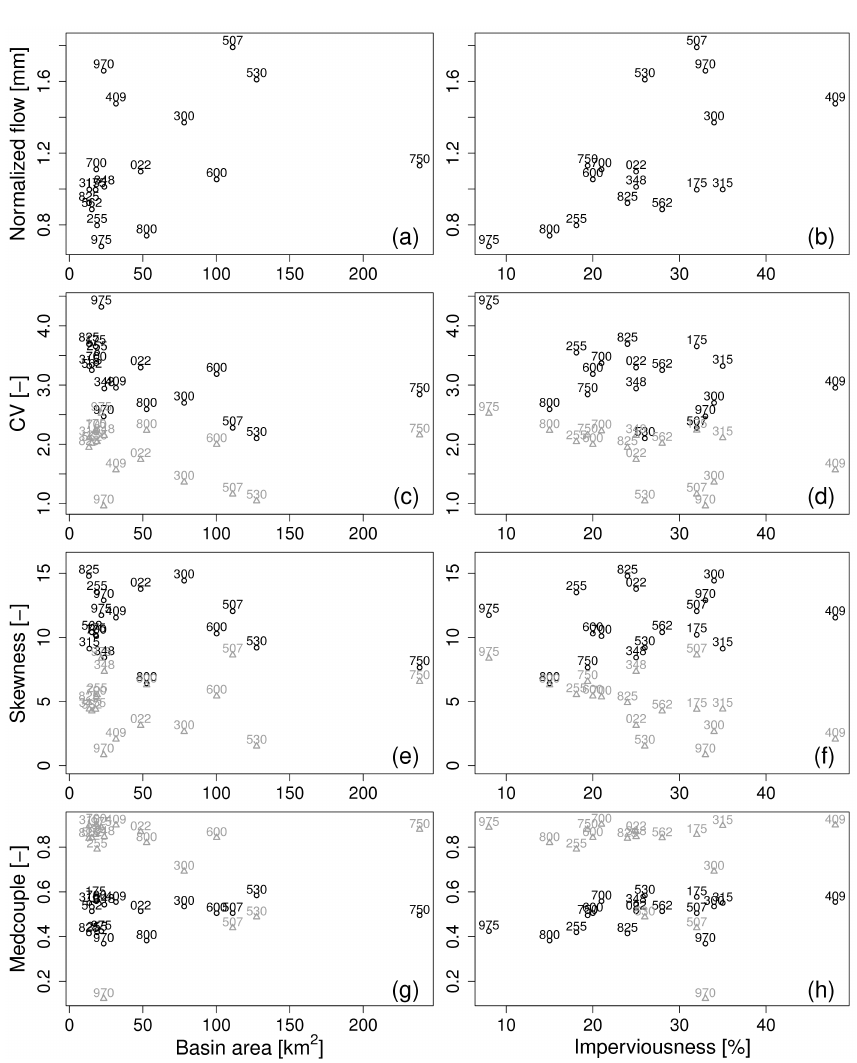
Figure 5. Scatter plots for mean normalised flow inter-amounts (a, b) , coefficient of variation (c, d) and medcouple values (e, f) for flows and inter-amount times versus basin area and imperviousness degree. Grey triangle symbols represent inter-amount times, black circles represent